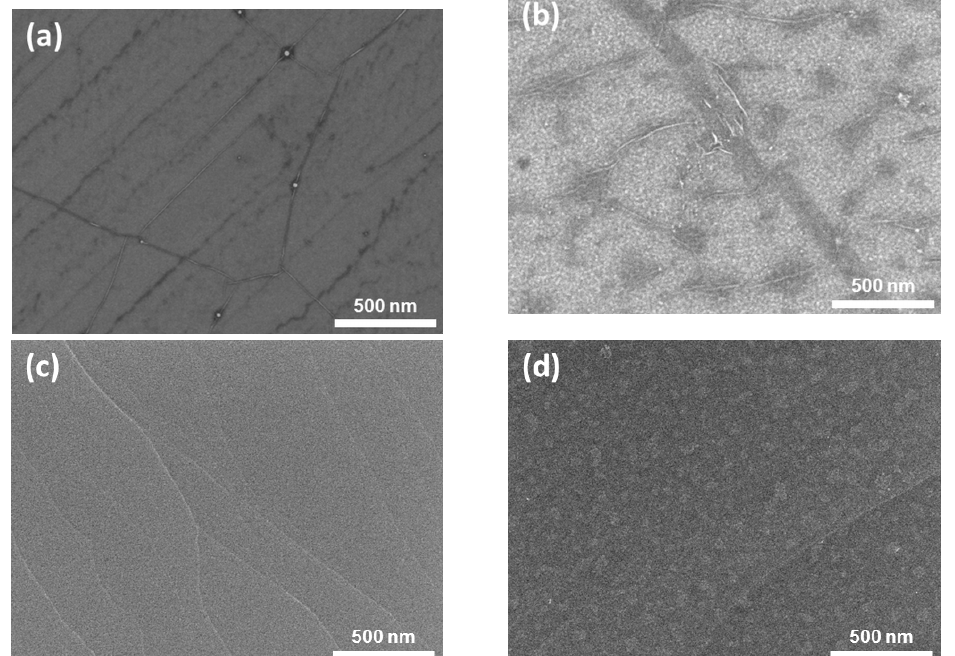
Figure 2. SEM images of pristine and PLD-treated graphene surfaces: ( a ) pristine CVD graphene, ( b ) CVD graphene functionalised with V 2 O 5 , ( c ) pristine epitaxial graphene on SiC and ( d ) the same functionalised with V 2 O 5 .